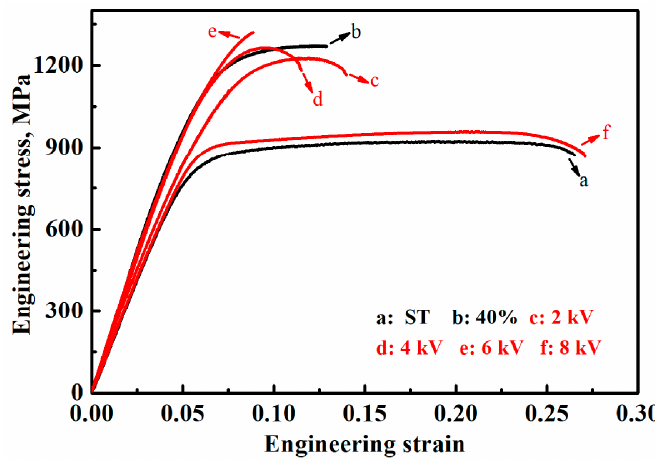
Figure 6. Engineering stress–strain curves of the ST specimen, cold-rolled specimen, and specimens treated by different charging voltages. Table 1. Mechanical properties of the ST specimen, cold-rolled specimen, and electropulsing-treated specimens.